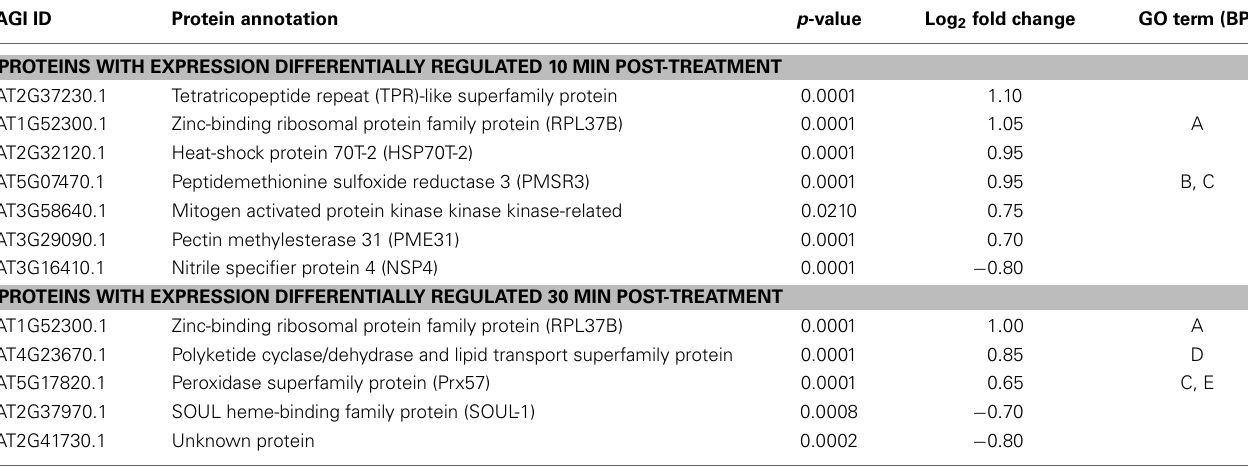
Table 1 | Annotation of proteins differentially expressed 10 and 30min after treatment of cells with 1nM AtPNP-A peptide.